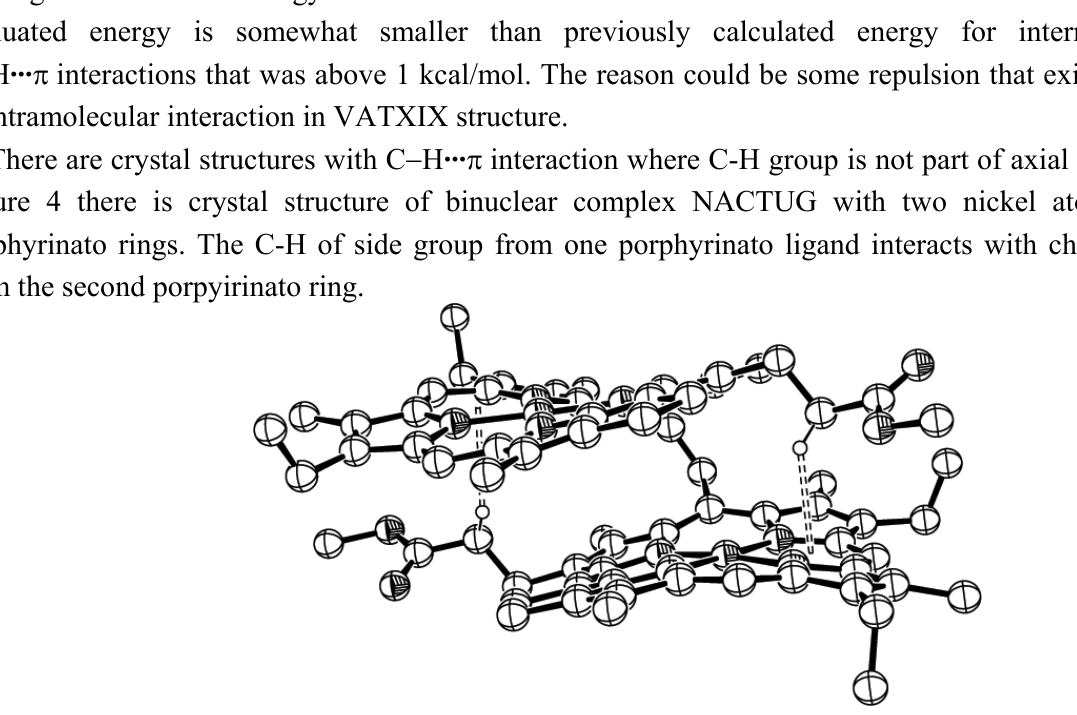
Figure 4. Crystal structure of NACTUG. Dashed lines represent C − H ··· π interactions. Some of atoms have been omitted for clarity. Coordinates are taken from